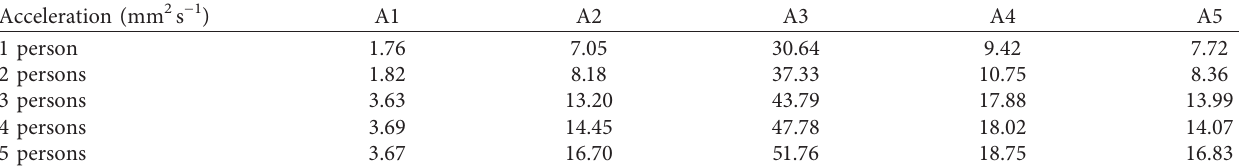
Table 2: The peak acceleration due to multiperson heel-drop tests.